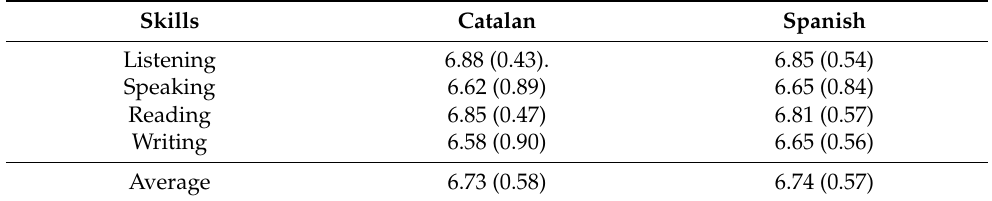
Table 1. Mean and standard deviation (in parentheses) of participants’ self-rated proficiency in Catalan and Spanish. Skills Catalan